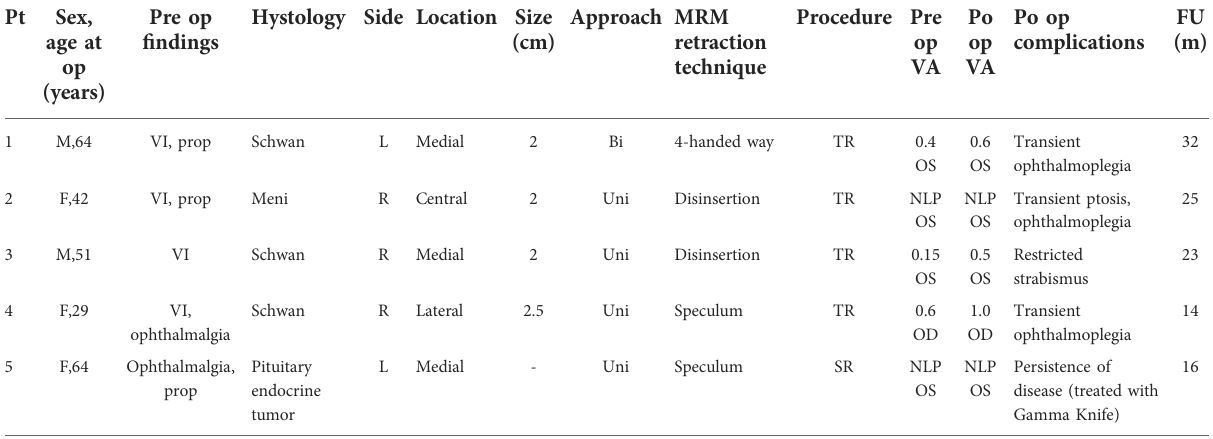
TABLE 1 Summary of patient fi ndings.